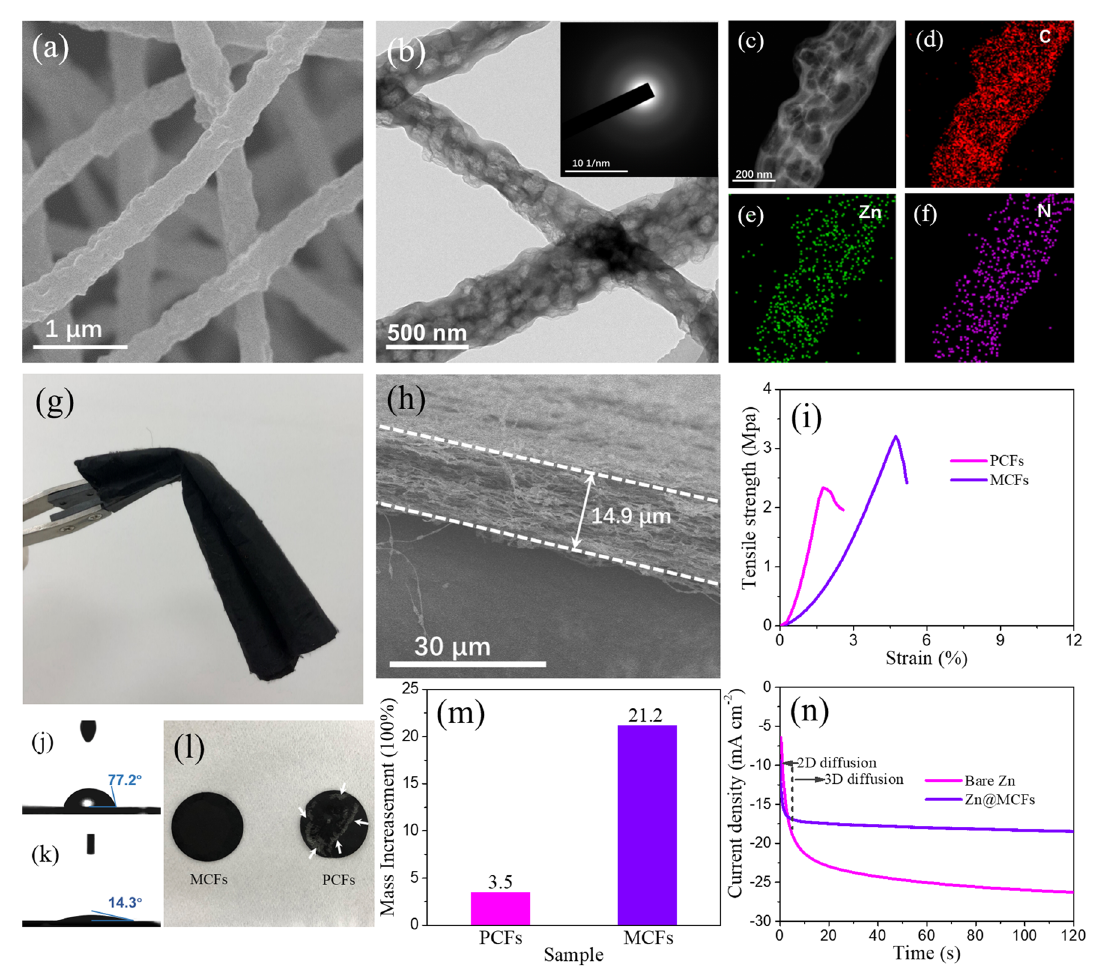
Fig. 1 a SEM image of MCFs. TEM characterization result of MCFs: b TEM image (inset shows the SAED pattern); c‑f HAADF image and corresponding EDS mappings of C, Zn, and N. g Digital photograph of MCFs cloth. h Side view of MCFs cloth under SEM. i Tensile test result of PCFs and MCFs. Contact angle test result of j Zn@PCFs, and k Zn@MCFs. l Digital photograph of PCFs and MCFs slices after soaked in electrolyte (2 M ZnSO 4 ) for 12 h and thorough air drying. m Electrolyte uptake ratio of PCFs and MCFs. n Chronoamperometries of bare Zn and Zn@MCFs with an applied overpotential of − 120